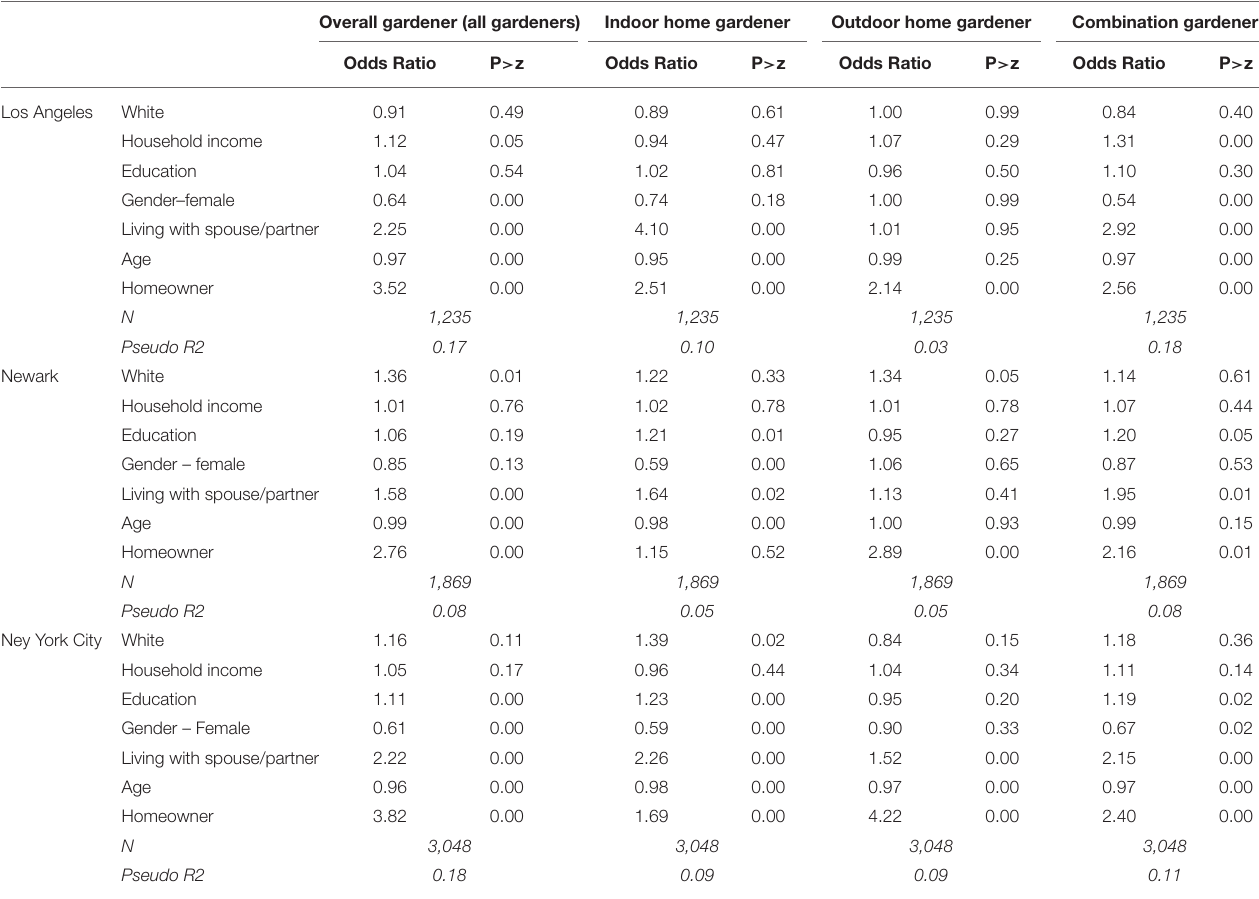
TABLE 4 | Multivariate logistic regression results assessing potential demographic predictors of overall (all gardeners), indoor, outdoor, and combination gardening across three cities (12 models). Overall gardener (all gardeners) Indoor home gardener Outdoor home gardener Combination